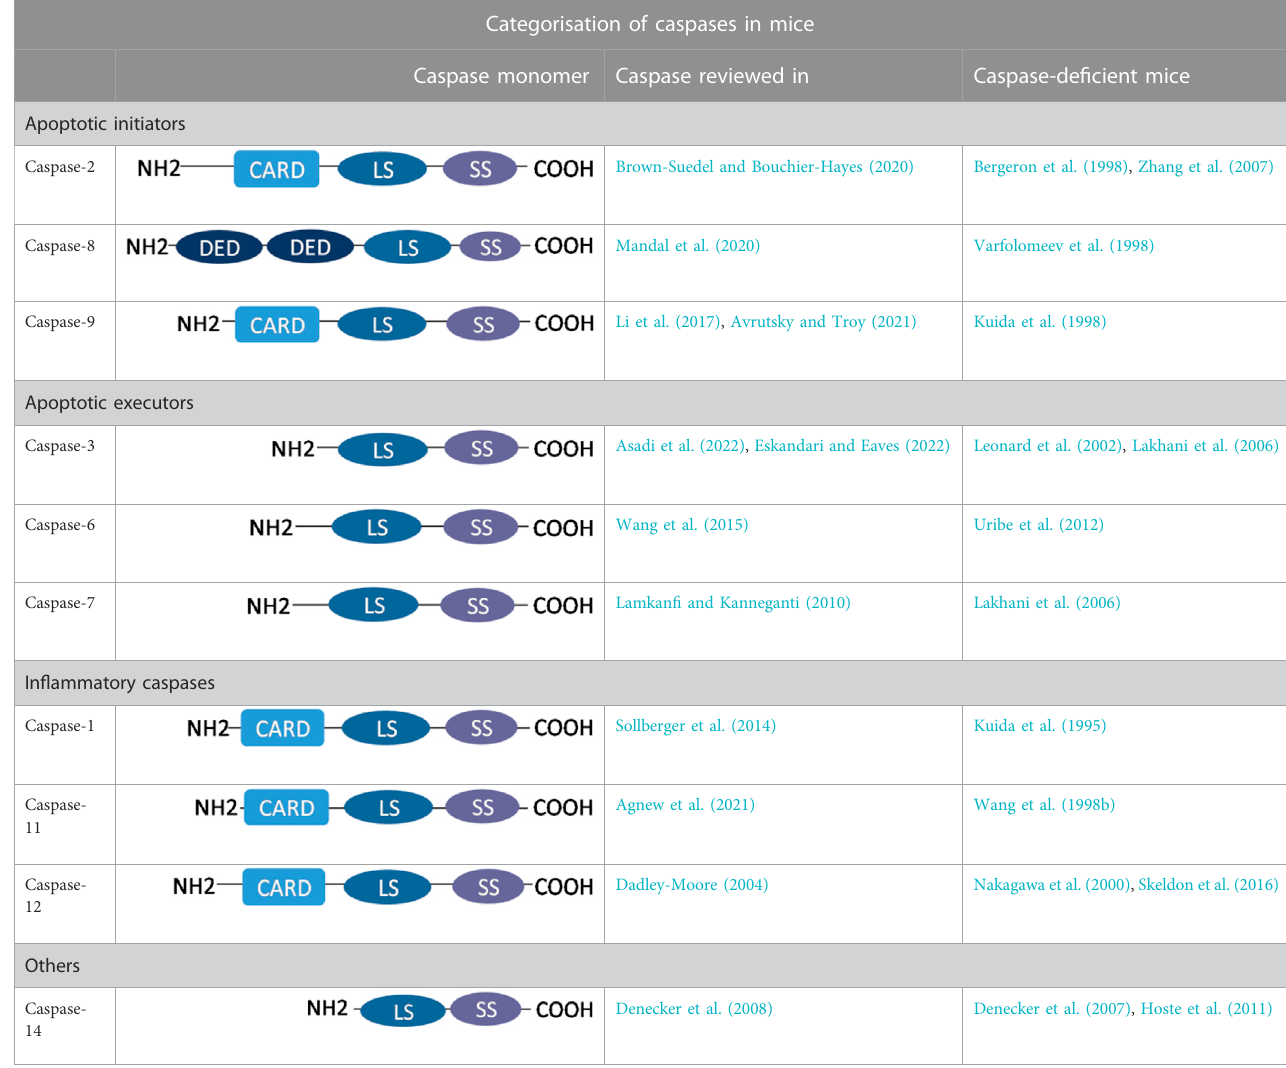
TABLE 1 Classical categorisation of caspases in mice as in Shalini et al. (2015). Detailed information of functions and molecular signalling and general phenotype of caspase-de fi cient mice for each caspase is given by individual studies listed in the